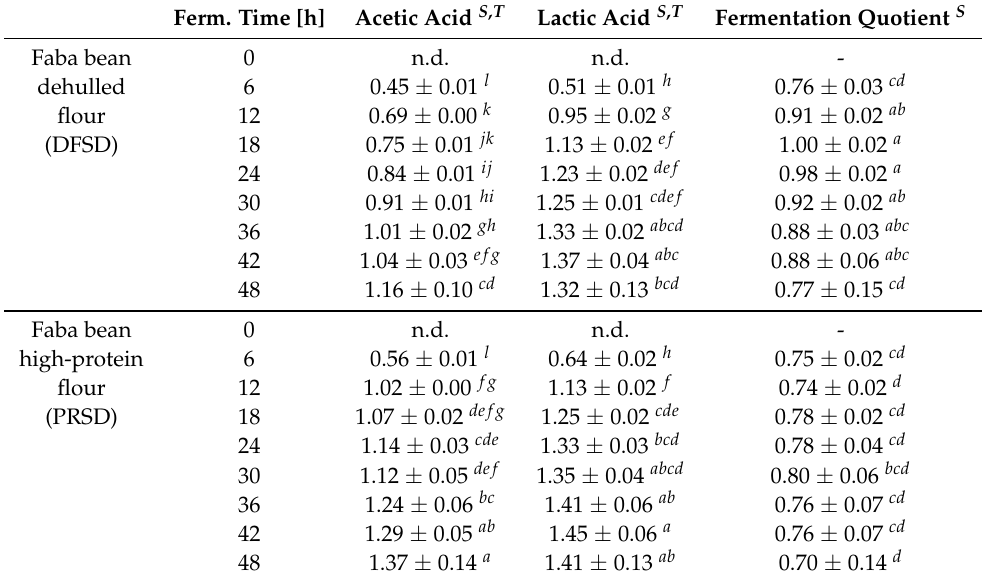
Table 2. Levels of lactic and acetic acid in faba bean fermentates, values expressed in %DM. Ferm. Time [h] Acetic Acid S , T Lactic Acid S , T Fermentation Quotient S Faba bean 0